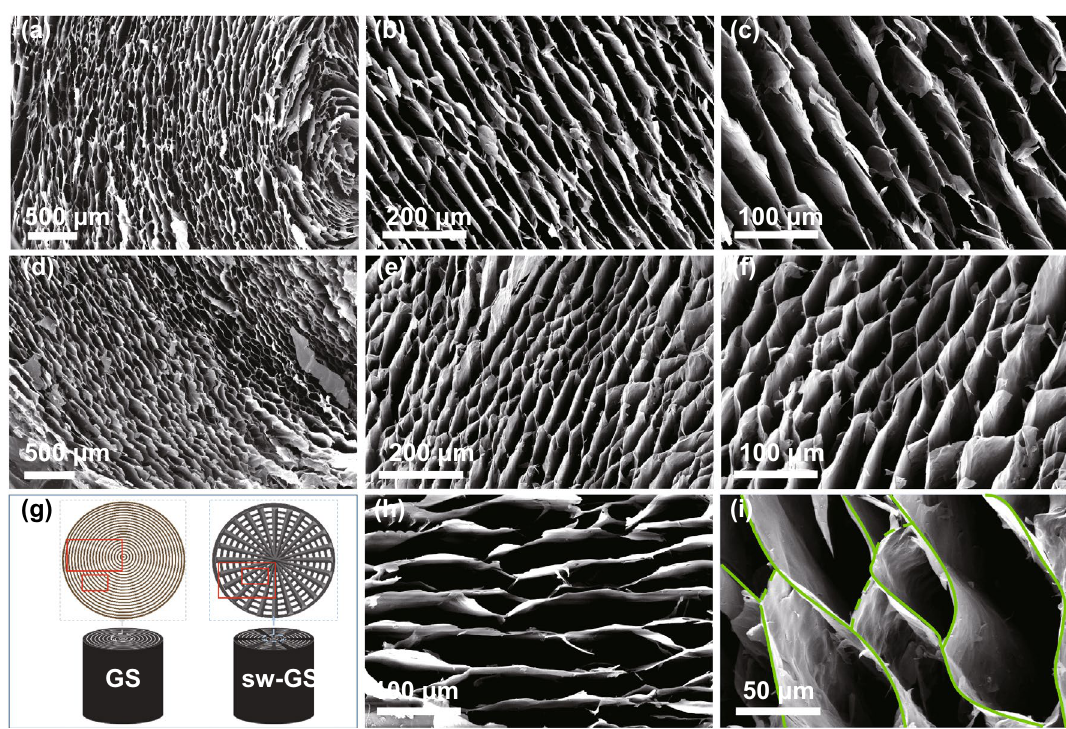
Fig. 2 SEM images of rGO aerogels prepared by a – c , h unidirectional freeze‑casting and d – f , i radial freeze‑casting at different magnification. g Schematic illustrations of morphologies for GS and sw‑GS, respectively. The SEM images displayed in a – f and h–i correspond to the regions marked with rectangular boxes in GS and sw‑GS. The interlaced structure of sw‑GS in i is outlined in green lines. (Color figure Fig. 2d–f correspond to the regions marked with rectangular boxes in sw‑GS in Fig. 2g right.